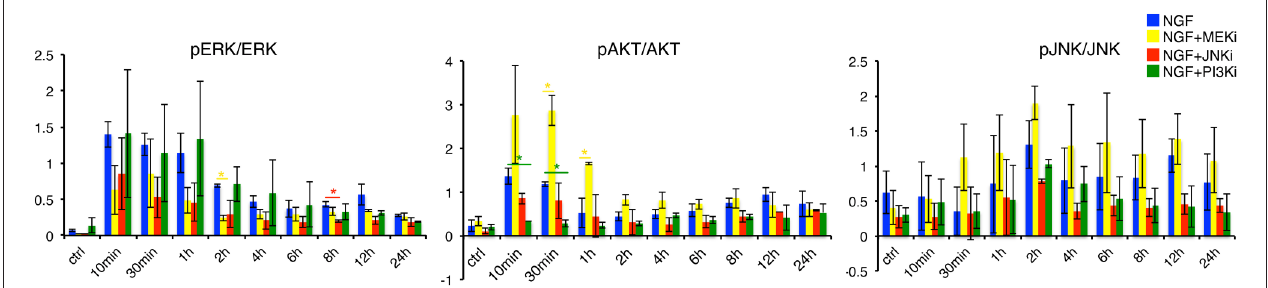
FIGURE 5 | Quantification of pERK, pAKT and pJNK levels under NGF and individual inhibitor treatments. Determination of pERK/ERK, pAKT/AKT and pJNK/JNK under NGF, NGF + MEKi, NGF + JNKi and NGF + PI3Ki treatment. Left panel: pERK/ERK levels decrease over time under NGF plus MEK and JNK inhibition. In contrast, PI3K inhibition shows a similar increase and sustained pERK/ERK levels over time compared to NGF treated PC12 cells alone. Interestingly, pAKT/AKT is increased under NGF+MEKi treatment, which is particularly significant in the early timepoints (30min and 1h) compared to NGF alone or the other two inhibitors. The latter two show decreased pAKT/AKT levels over time (middle panel). A * denotes a p -value < 0.05 , data points obtained in duplicates and